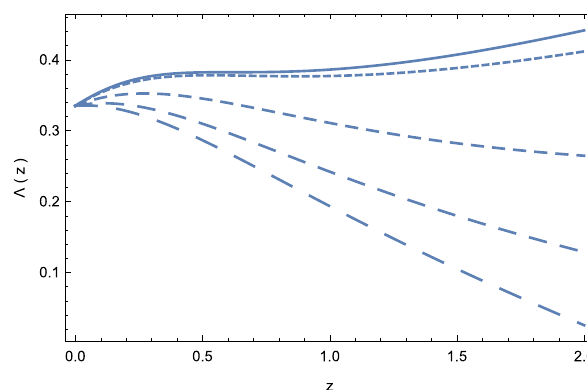
(cid:11) (cid:12) Fig. 9 VariationasafunctionoftheredshiftoftheLagrangemultiplier (cid:12) (cid:11) ˜ Q , ˜ T = α ˜ Q ˜ T ˜ Q , ˜ T = α ˜ Q ˜ T for (cid:4)( z ) for the geometry-matter coupling function F M = 0 . 98, and for different values of α : α = − 0 . 72 (dotted curve), α = − 0 . 77 (short dashed curve), α = − 0 . 80 (dashed curve), α = − 0 . 81 (long dashed curve), and α = − 0 . 82 (ultra-long dashed curve). To integrate the system of cosmological evolution equations we have used the initial conditions h ( 0 ) = 1, (cid:18)( 0 ) = 0 . 455, and (cid:4)( 0 ) = 0 . 335 The evolution of the Lagrange multiplier (cid:4)( z ) , repre- sentedinFig.9,isstronglydependentonthenumericalvalues of α , and indicates a complex behavior. For larger values of α , (cid:4)( z ) shows an oscillating behavior, with increasing phases alternating with decreasing ones. For smaller values of α